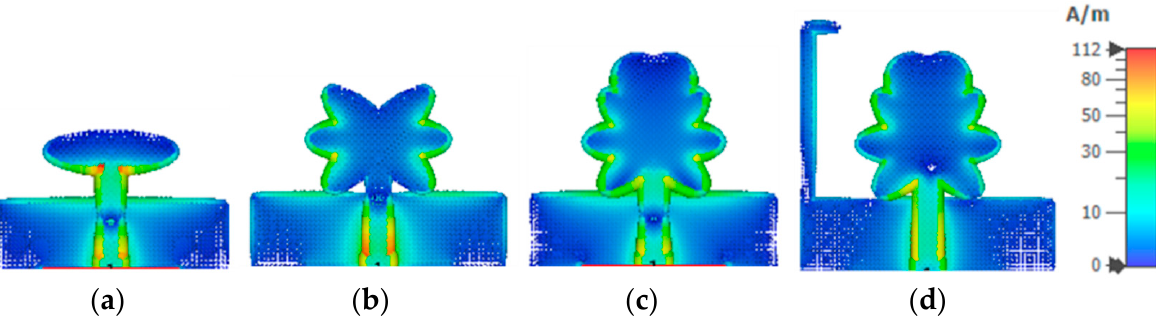
Figure 3. Surface current distribution at different stages of the proposed UWB antenna: ( a ) 5.2 GHz ( b ) 10.7 GHz ( c ) 8.2 GHz, and ( d ) 8 GHz.